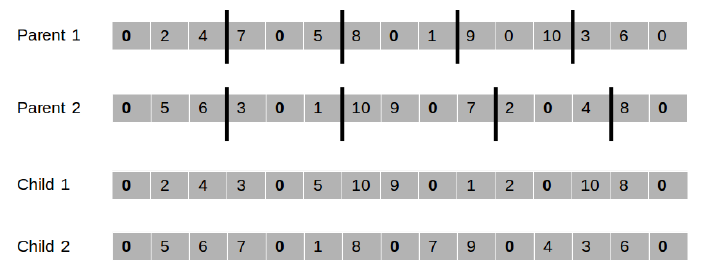
Figure 3. Ordered crossover